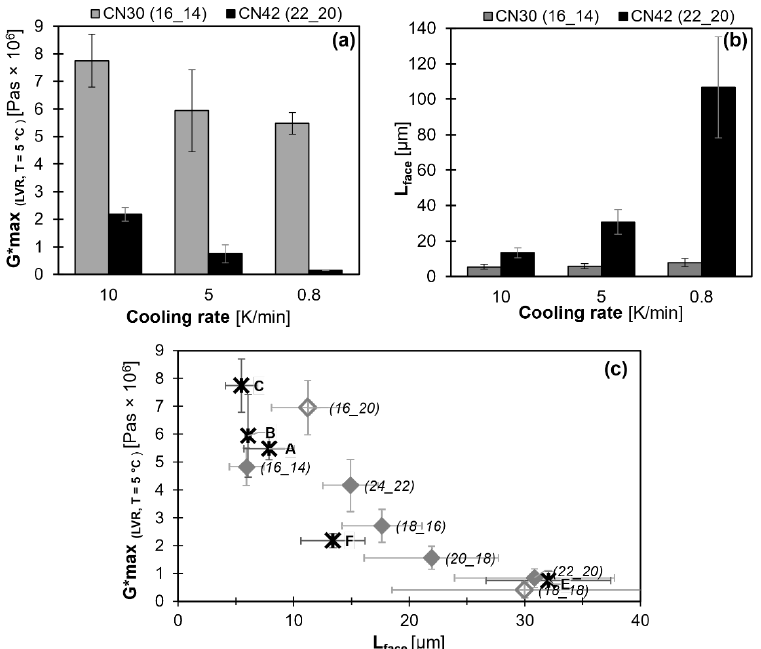
Figure 11. Effect of the cooling rate on mono-ester gels (10% [ w / w ] of the respective WE and MCT oil) for ( a ) 𝐺 𝑚𝑎𝑥∗ (within LVR; T = 5 °C) and ( b ) L face ; ( c ) relationship between microstructure (L face ) and viscoelastic behavior ( 𝐺 𝑚𝑎𝑥∗ ). A: CN 30; 0.8 K/min, B: CN 30; 5 K/min, C: CN 30; 10 K/min, D: CN 42; 0.8 K/min exceeds the range of face length displayed and is not shown, E: CN 42; 5 K/min, F: CN 42; 10 K/min. Filled diamonds: homologous series of ∆𝐶𝑁 = +2 , hollow diamonds: not part of homologous series. All WE are denoted as (FaOH_FA).